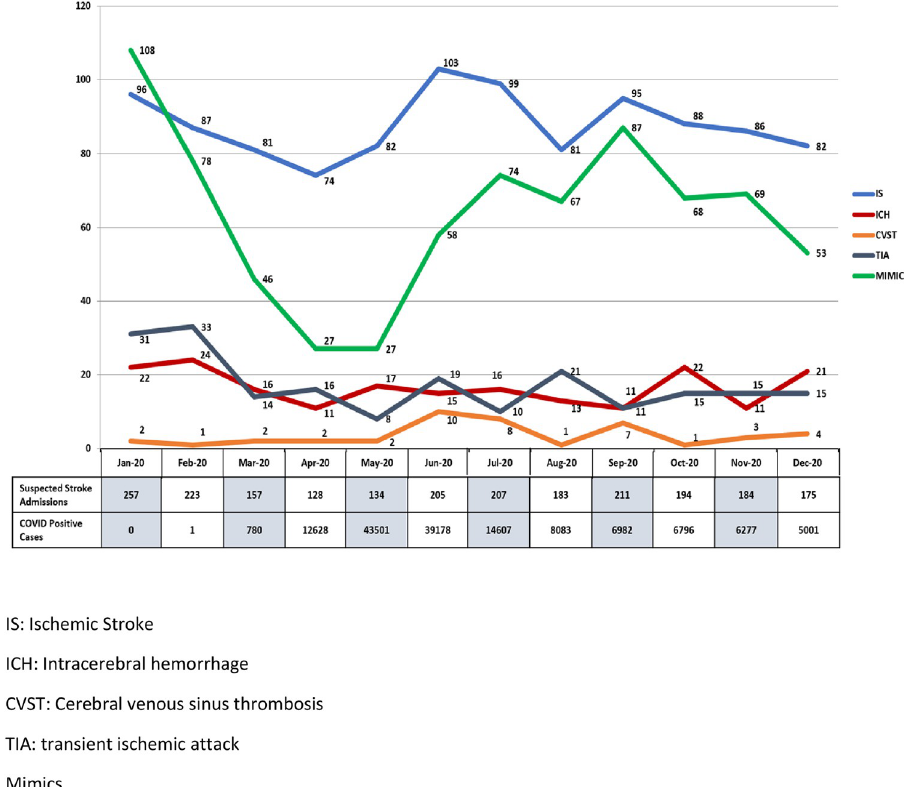
Fig 1. Distribution of different discharge diagnosis per month during the pre-COVID-19, peak of the pandemic and in the six months following the peak of the COVID-19 pandemic. The number of monthly COVID-19 cases are shown in the legend below. The “P” values are for group comparisons between the pre-pandemic, pandemic and post- pandemic time period.